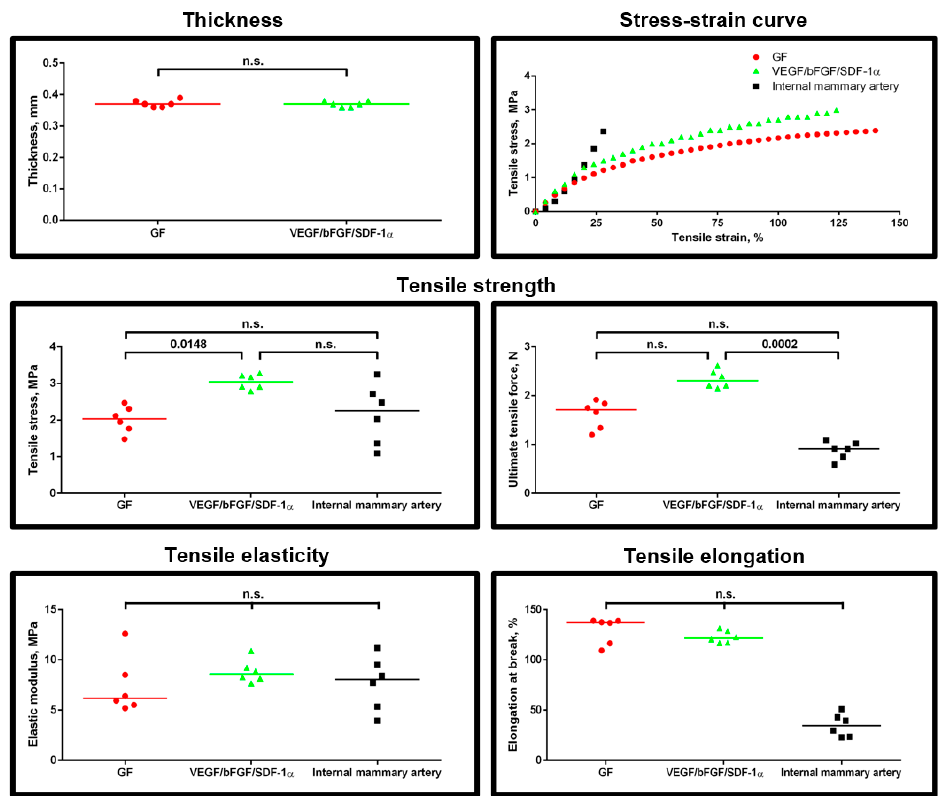
Figure 2. Two-layer structure endows the grafts with improved mechanical properties. Mechanical testing of the grafts modified exclusively with either VEGF, bFGF or SDF-1 α (merged in GF group due to being one-layer), or with all three factors having a two-layer structure. Data are represented as a univariate scatterplot with the median, each dot represents a measurement from one graft, Kruskal–Wallis test with the further Dunn’s multiple comparisons test, p values adjusted for multiple comparisons are reported in a numerical manner, n.s. is for not significant. For a stress-strain curve, each dot represents the median of respective measurements for all six graft samples from the testing.